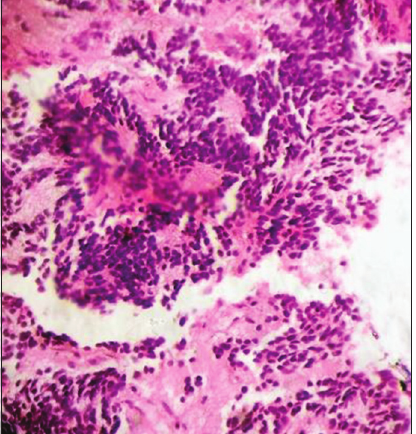
Figure 1: X-Ray chest and abdomen showing ground glass appearance of massively distended abdomen and raised diaphragm